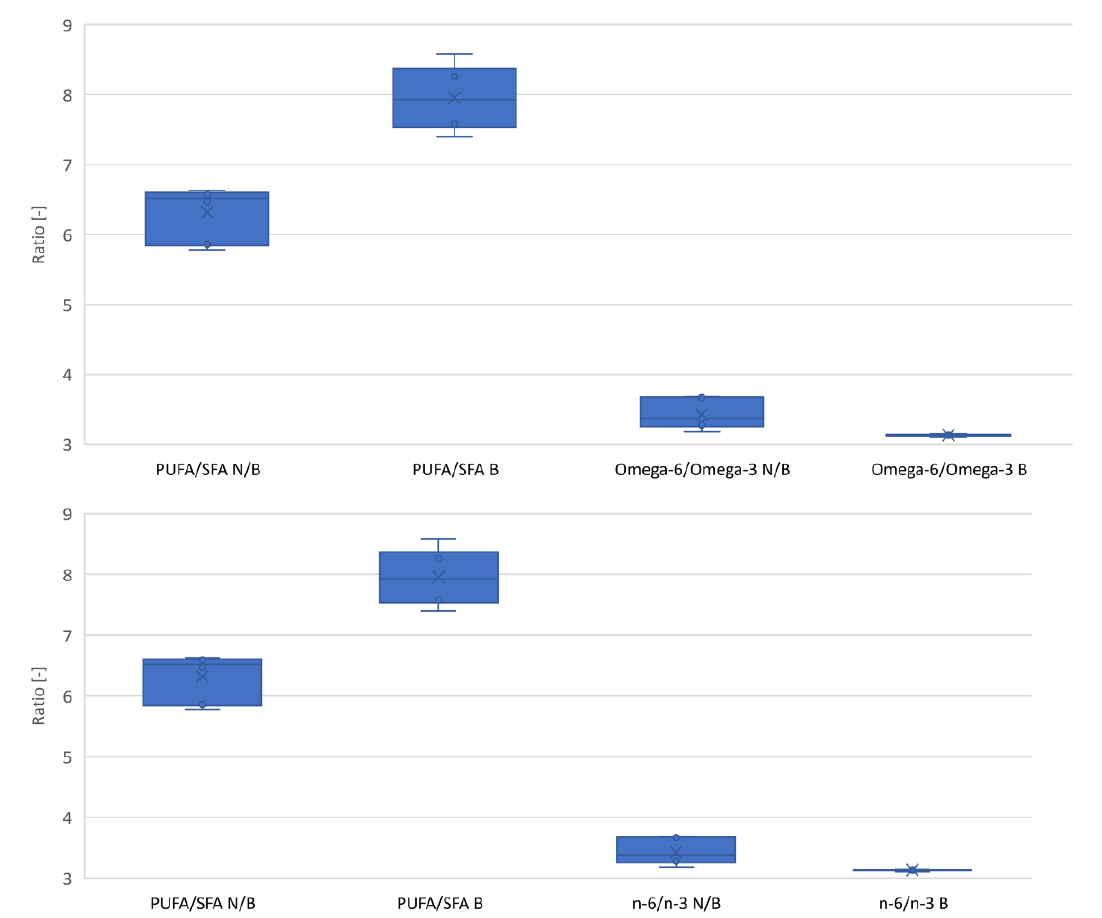
Figure 4. Change in the SFA/PUFA and omega-6/omega-3 ratios due to the bleaching process. N/B — unbleached oil; B — bleached oil.